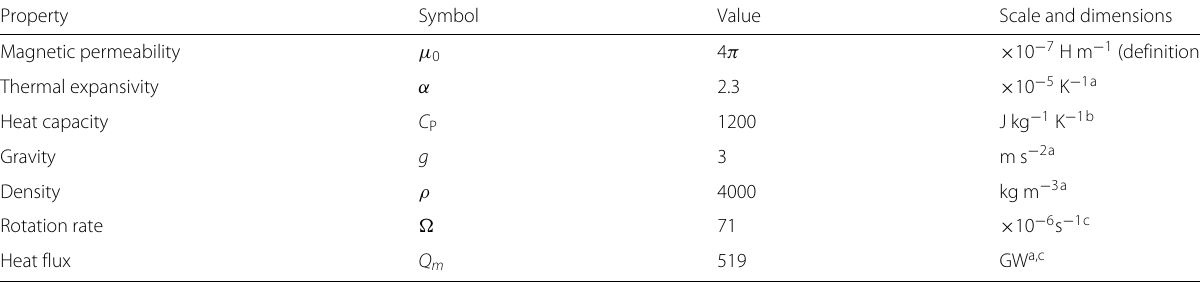
Table 1 Thermophysical properties for Mars mantle relevant to dynamo activity Property Symbol Value Scale and dimensions Magnetic permeability